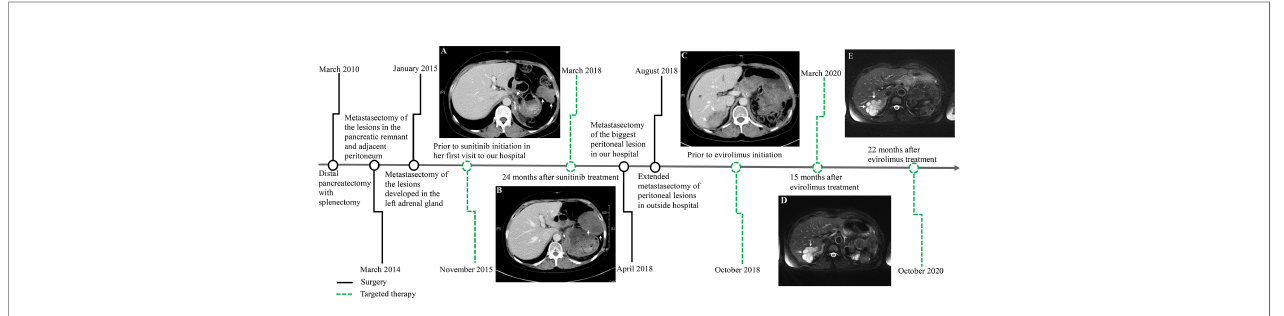
FIGURE 1 | Time axis of repeated surgery and targeted therapy for the metastatic pancreatic solid pseudopapillary neoplasm. Computed tomography scan showing multiple tumors in the peritoneum and retroperitoneum (white arrow) prior to sunitinib treatment after repeated surgery (A) . Tumors rapidly increased in size 24 months after sunitinib treatment (B) . There was a 52×36 mm, well-de fi ned mass with heterogeneous contrast enhancement in the right lobe of the liver (white arrow) prior to evirolimus treatment after extended metastasectomy (C) , which maintained tumor volume stability 15 months (D) and 22 months (E) after evirolimus